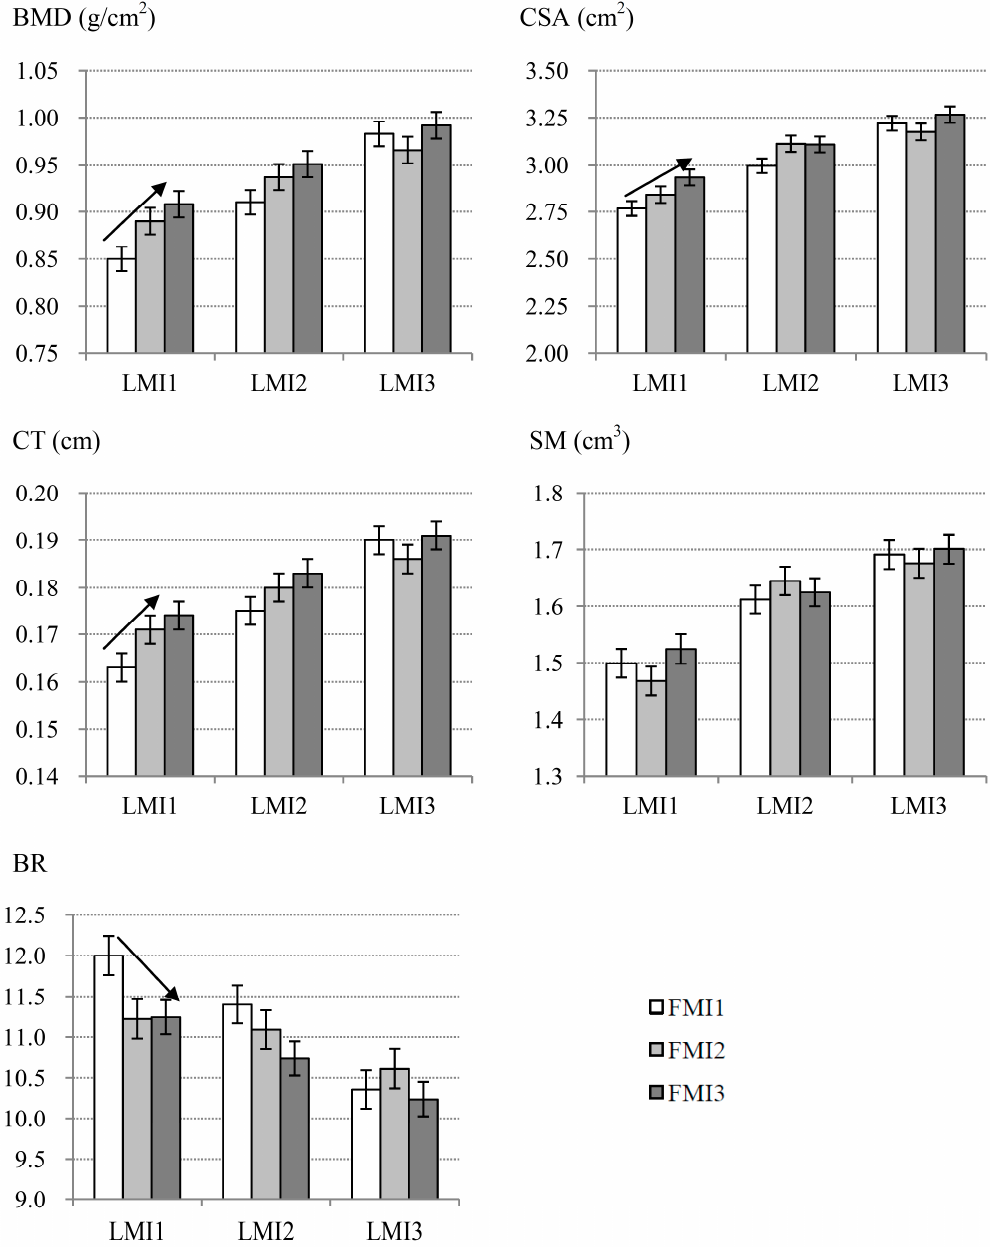
Figure 2. Differences of mean values of bone parameters among FMI tertiles in each LMI subgroup. Mean values were calculated after adjusting for the confounders, such as age, height, physical activity, smoking status, drinking status, calcium supplement intake, dietary calcium intake and dietary protein intake. Arrows indicate the significant trends ( p < 0.05) for bone phenotypes with the FMI in the LMI1 subgroup.